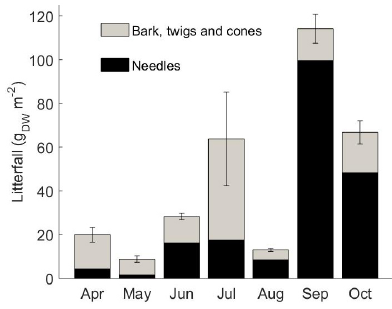
Figure 4. Monthly litterfall of bark, twigs, and cones (grey, g(DW)m − 2 ) , and the fraction of needles in litterfall (black, g(DW)m − 2 ) at the SMEAR II stand from April to October 2015. Error bars indicate the standard error of monthly total litterfall from 21 litter